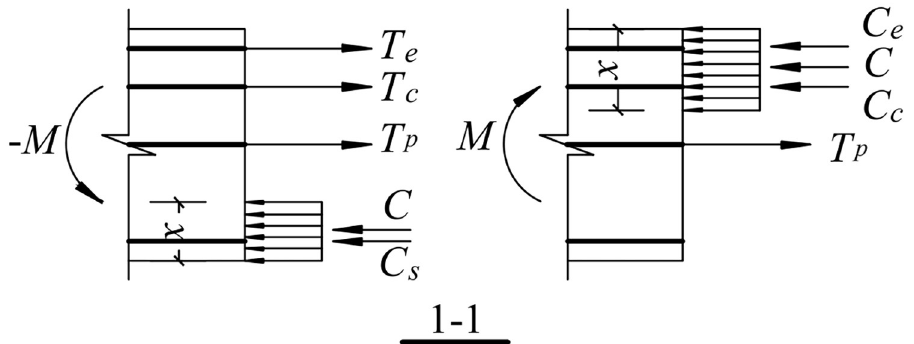
Fig 28. Calculation diagram of the bending moment in the normal